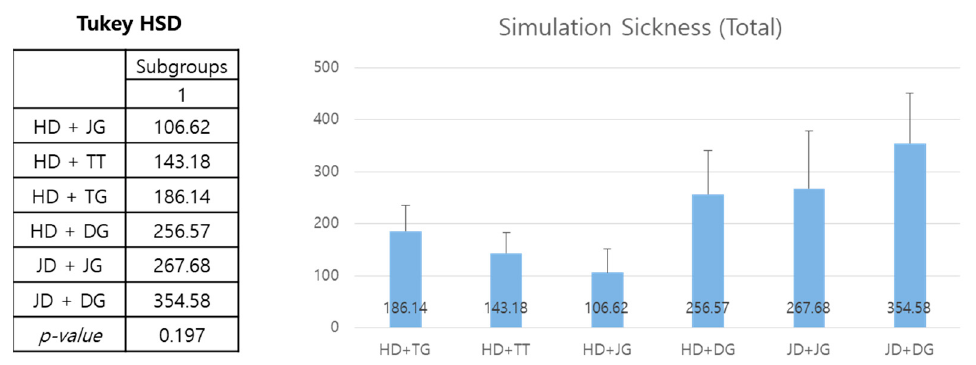
Figure 11. Simulator Sickness Questionnaire (SSQ) scores (total) for the six interfaces.